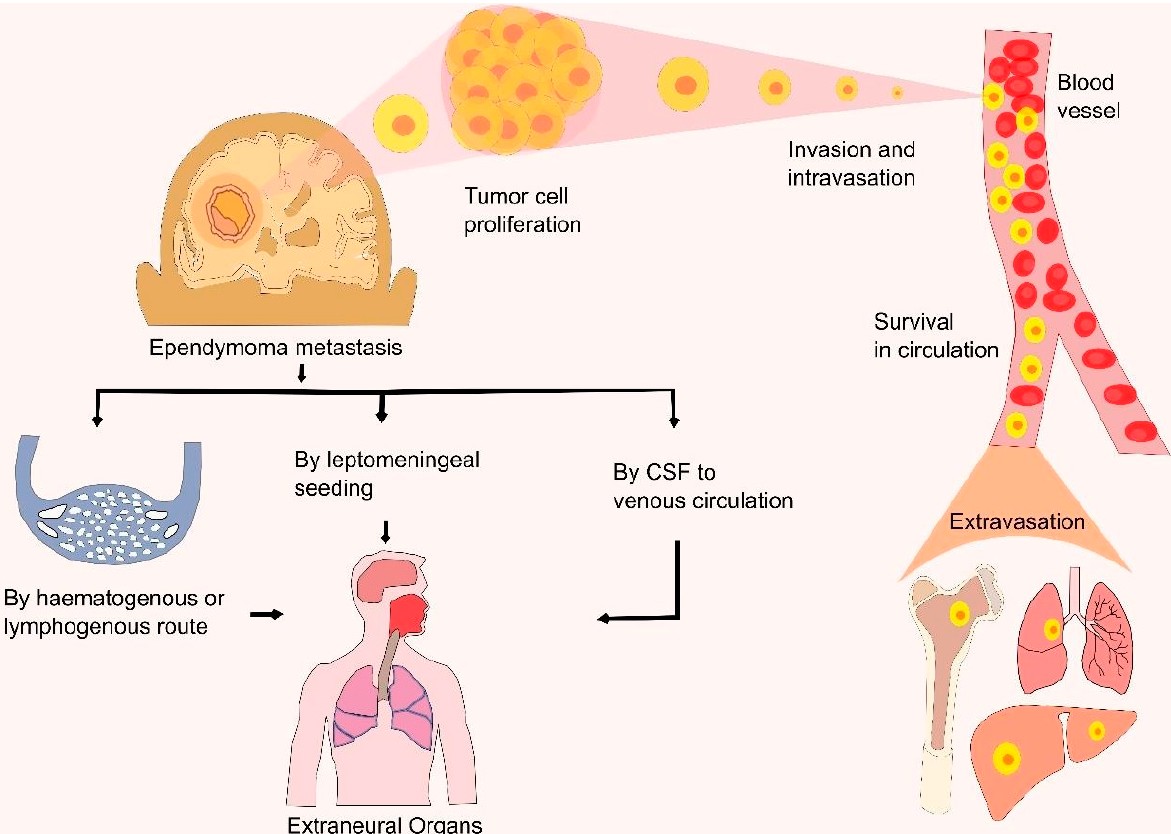
Figure 3. Metastasis of ependymomas. This figure illustrates the dissemination of an ependymal tumor cell from its primary site to the secondary site. The ependymoma metastasizes to an extraneural organ (e.g., skull, lungs, liver, bone, or lymph nodes) via several routes, including the haematogenous or lymphogenous routes. When tumor cells separate from their primary tumor, they intravasate into the blood vessels, circulate, and extravasate into their target